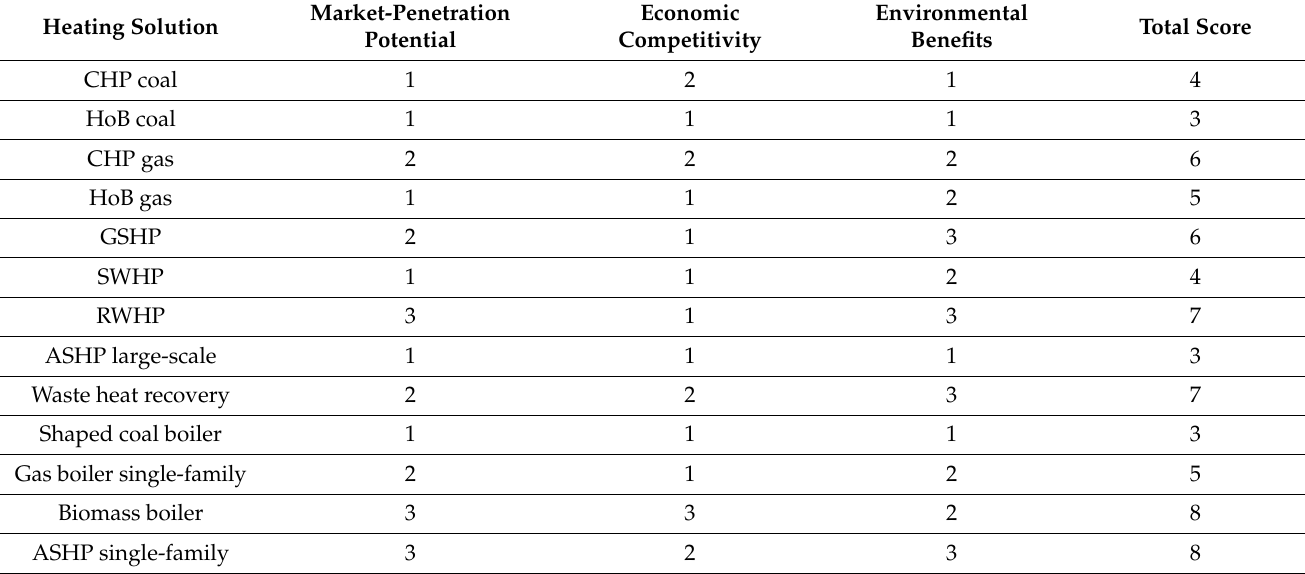
Table 1. Feasibility scoring of each heating solution 1